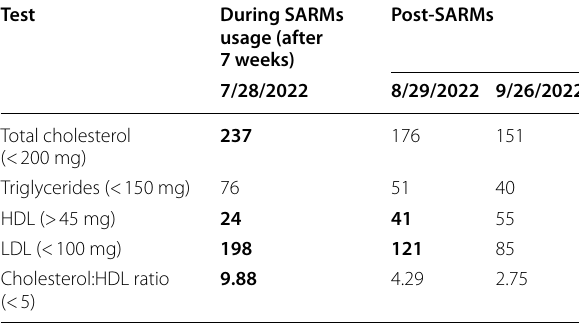
Bold indicates value out of normal range